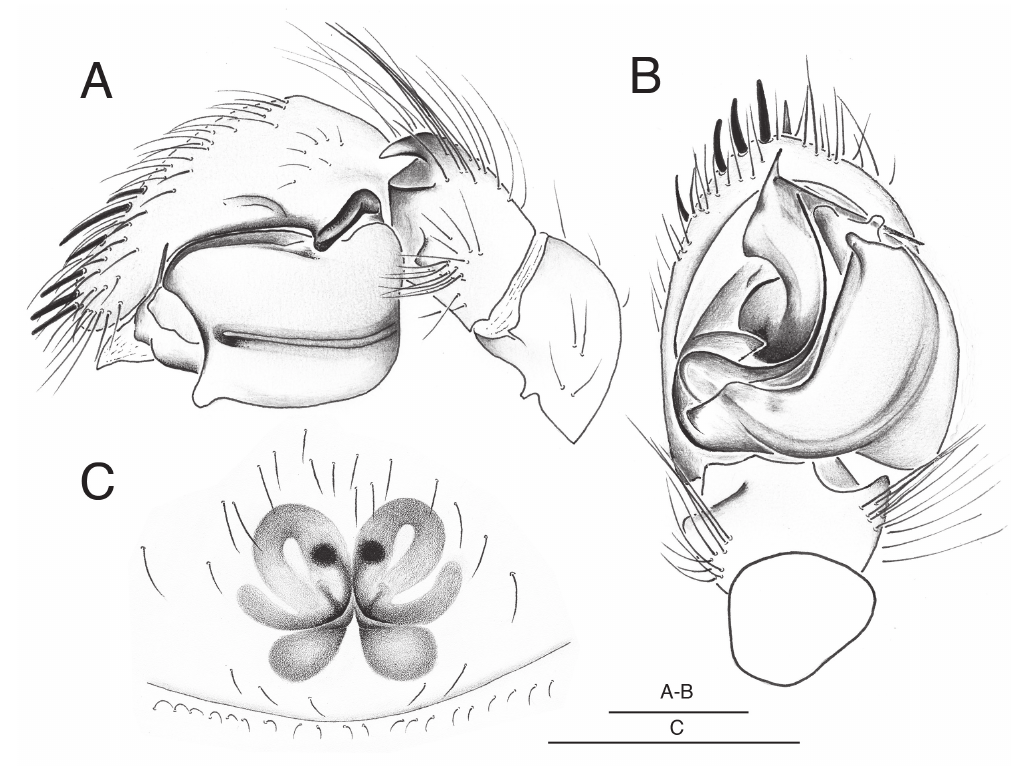
Fig. 3. Ballomma erasmus gen. et sp. nov. A–B . Holotype, ♂. C . Paratype, ♀. A . Male palp, retrolateral view. B . As preceding, ventral view. C . epigyne, ventral view. Scale bars: 0.5